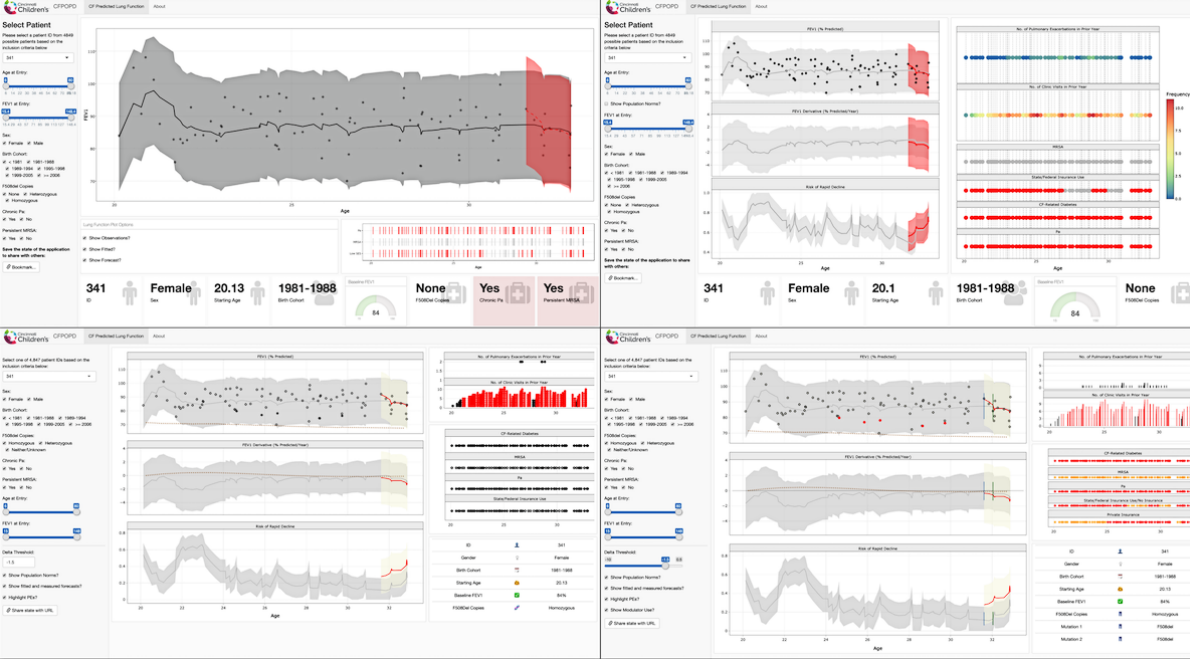
Figure 1. Progression of Cystic Fibrosis Point of Personalized Detection (CFPOPD) across multiple versioned releases. From versions 1 (top left) to 3 (top right), additional pulmonary function plots for the rate of forced expiratory volume in 1 second (FEV1) change and the risk of rapid decline was added. In version 5 (bottom left), users were given the ability to adjust the delta threshold to calculate the risk of rapid decline, and covariate information was moved to a table in the farthest right panel rather than a banner at the bottom of the application screen. The addition of a checkbox to visualize the initiation of modulator use was a key feature in version 7 (bottom